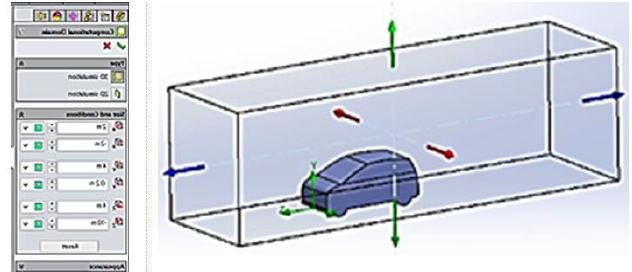
Fig. 8. Fluid domain for 3-D model of Daihatsu Mira X